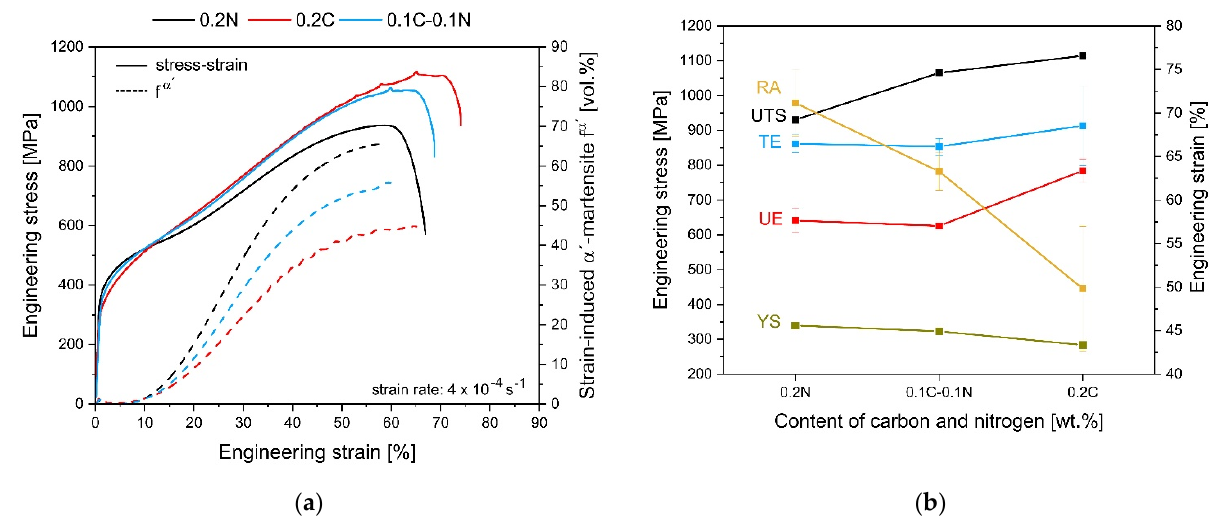
Figure 2. Tensile test results of the investigated steels: ( a ) engineering stress–strain curves and the evolution of strain-induced α (cid:48) -martensite volume fraction f α (cid:48) at RT and ( b ) average mechanical properties as a function of the nitrogen and carbon content of the steels.